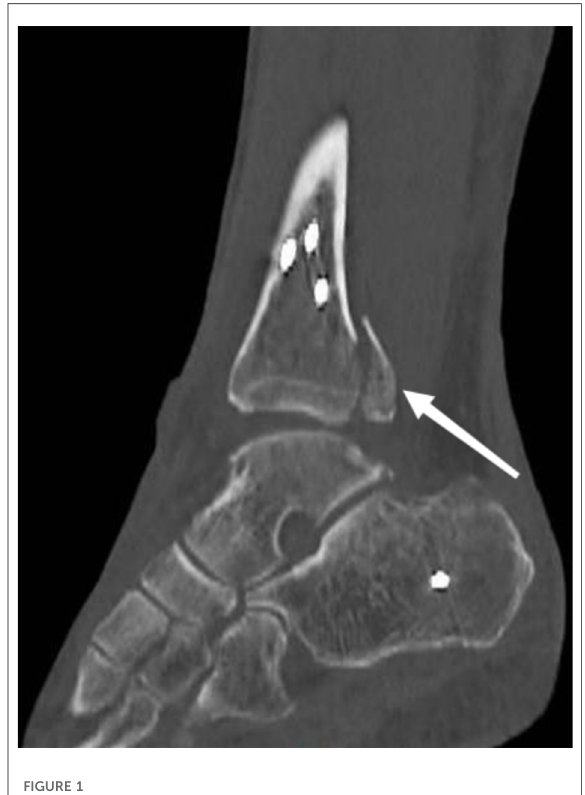
FIGURE 1 Ankle fracture after